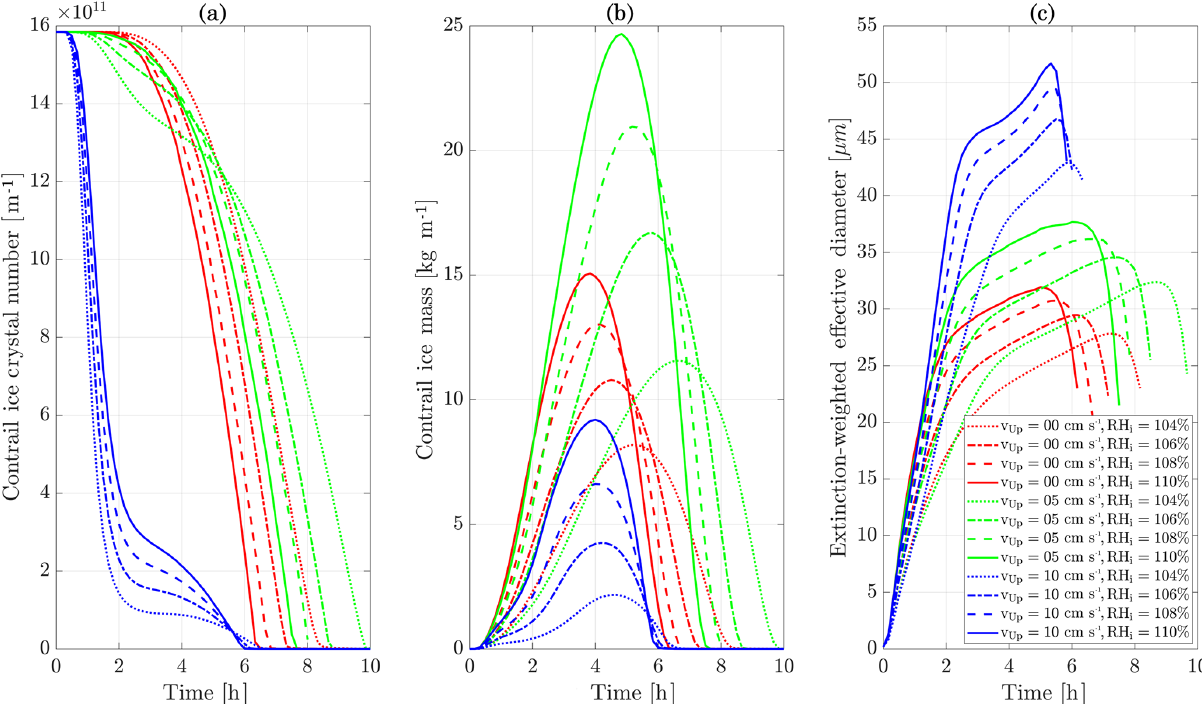
Figure 11. Contrail ice crystal number (a) , ice crystal mass (b) , and extinction-weighted effective diameter (c) when varying background relative humidity and the contrail updraft velocity